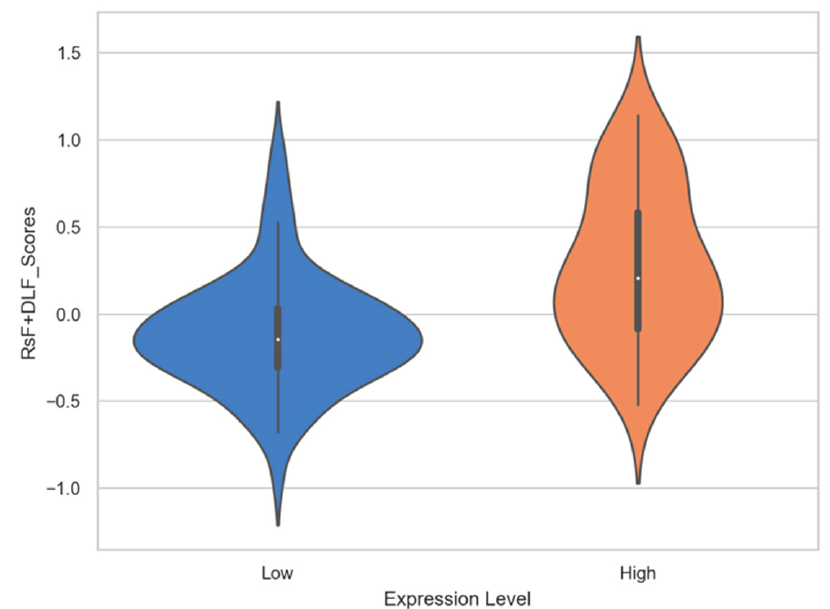
Figure 7. The violin plot of RsF+DLF_Scores distributions between the high PD-L1 expression level group and low expression level group .